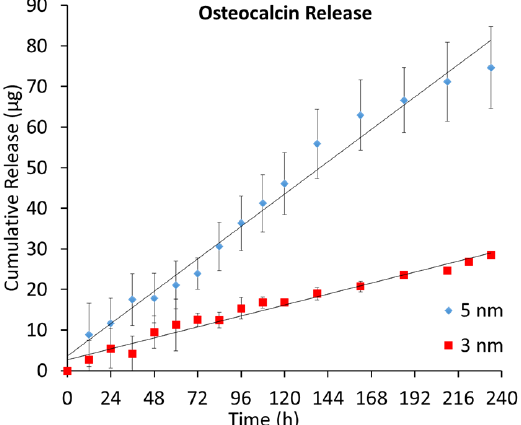
Figure 3. Average cumulative release of osteocalcin from 3 and 5 nm nanochannel Figure 3 . Average cumulative release of osteocalcin from 3 and 5 nm nanochannel membranes ( n = 3). Experimental points were collected every 12 h for 10 membranes ( n = 3). Experimental points were collected every 12 h for 10 days.